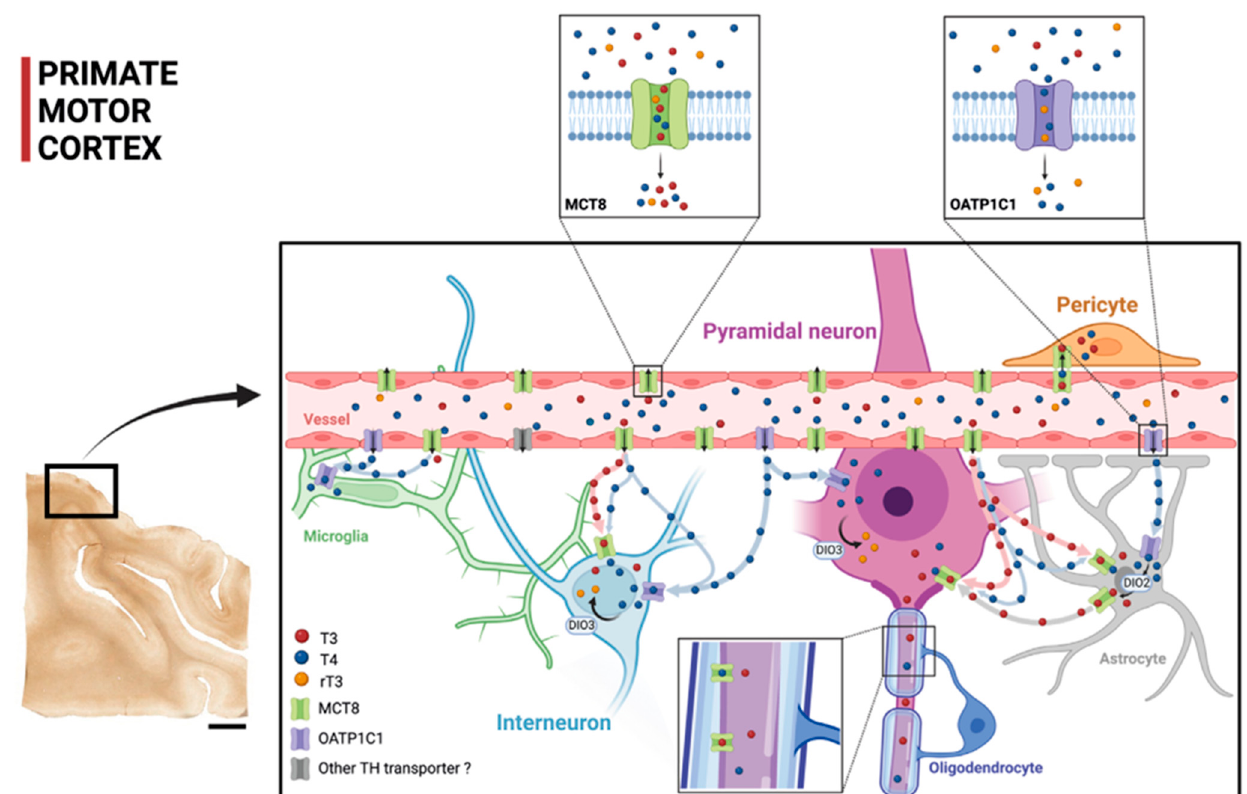
Figure 9. Model of TH transport in human and primate motor cortex based on our contribution. The two small frames above show the TH transport affinities for MCT8 and OATP1C1, with MCT8 facilitating primarily the transport of T3 and T4 and OATP1C1 facilitating the transport of T4 and rT3 (see legend for color key). The scheme shows the distribution of the transporters MCT8 and OATP1C1 and the possible flow of T3 and T4 in the human and non-human primate motor cortical cells. Circulating T3 and T4 pass through the vascular endothelium to the brain parenchyma, relying primarily on MCT8 and on, to a much lesser extent, OATP1C1 and other transporters. Then, T3 and T4 are transported to the intracellular medium by MCT8 and/or OATP1C1 in different target neural cells. T3 enters into astrocytes and some interneurons and pyramidal cells (more abundantly in non-human primates). T4 is converted into T3 by astrocytic DIO2, providing additional T3 to nearby neural cells. DIO3 at the neuronal cell membrane catalyzes the conversion of T4 to rT3 and T3 to T2. T4 enters into neural cells, where it can be stored. DIO2: Deiodinase 2, DIO3: Deiodinase 3. Scale bar = 4000 µ m (Created with